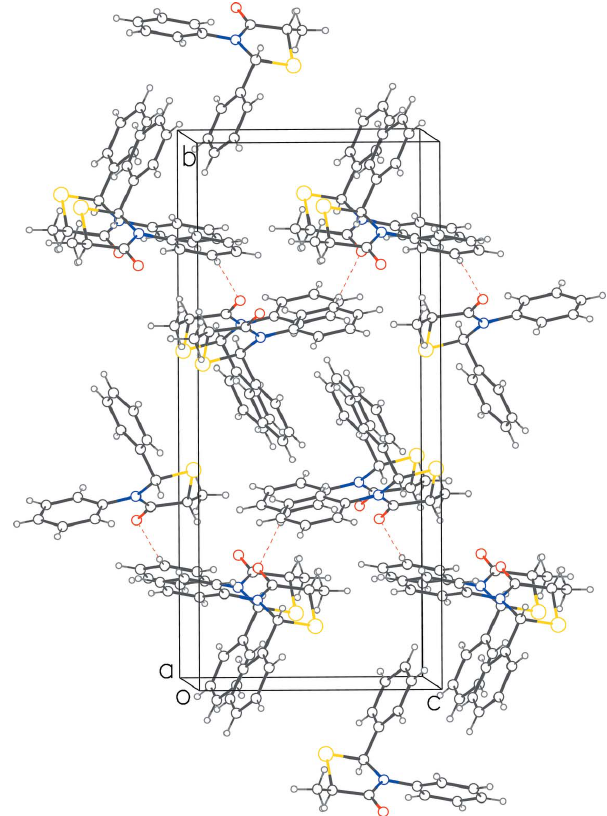
Figure 2 Packing diagram of the title compound, with red dotted lines representing